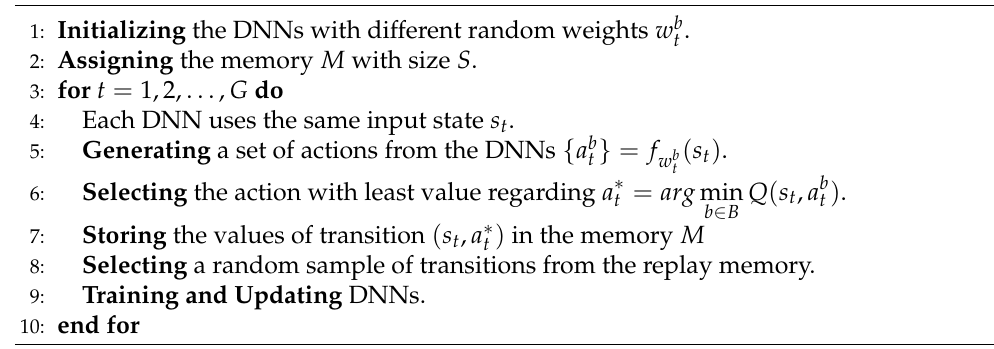
Figure 3. Architecture of the proposed distributed deep reinforcement learning-based algorithm. Algorithm 2 Distributed Deep Reinforcement Learning-Based